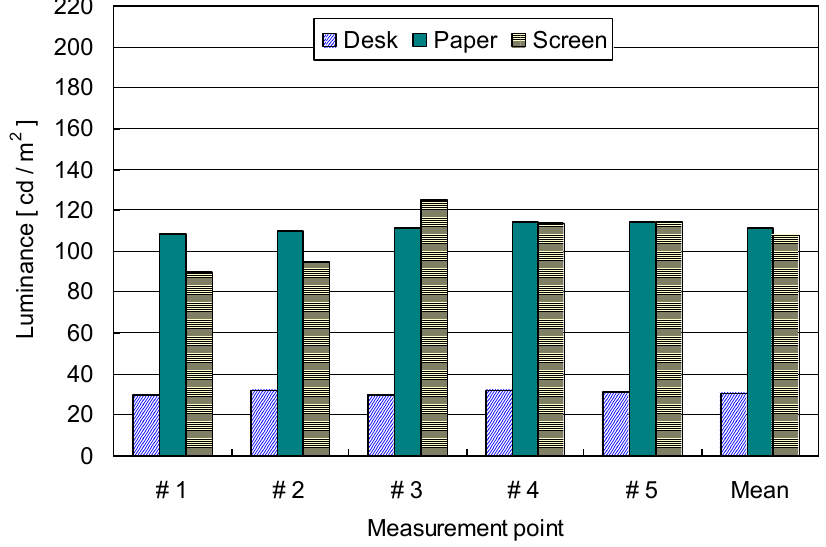
Figure 9. Variation of luminance on desktop and computer screen (500 lx condition).